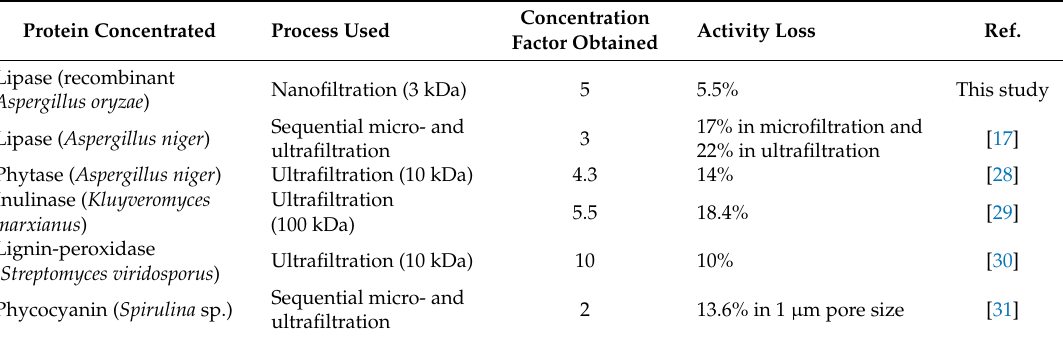
Figure 1. SDS-PAGE and Zymogram. ( A ) SDS-PAGE for the culture supernatant of Aspergillus oryzae expressing Fusarium heterosporum lipase (FHL) (UC: unconcentrated, C 10×: concentrated 10-fold). ( B ) Zymogram for the detection of lipase produced from recombinant A. oryzae . ( C ) SDS-PAGE of the lipase from Thermomyces lanuginosus (CalT). ( D ) Zymogram of CalT. (X 3.000 at dilution 3.000-fold, X 10.000 at dilution 10.000-fold). SM: standard marker. Table 2. Concentration factors and activity loss obtained in previous processes involving the concentration of proteins using membrane separation technologies.